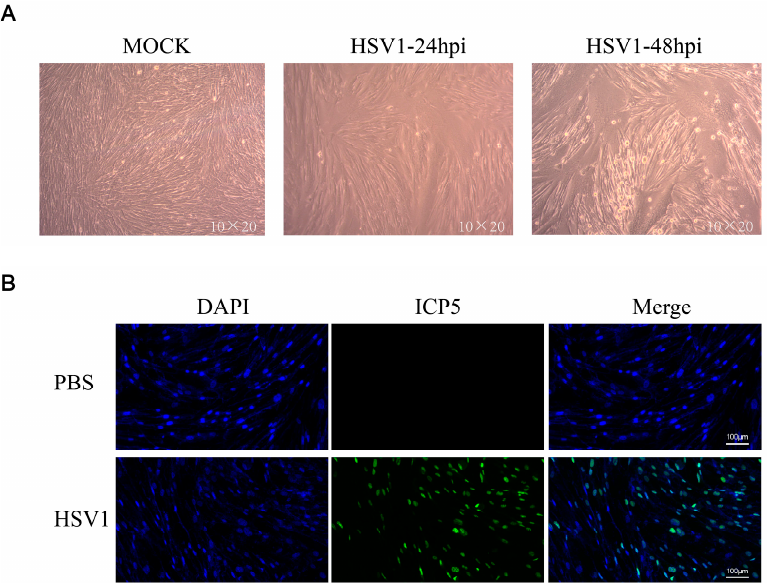
Figure 1. HSV-1 effectively infected KMB17 cells. ( A ) KMB17 was infected with HSV-1 (MOI = 0.1), cultured in 2% serum maintenance solution for 24 or 48 h, and recorded under microscope (10 × 20). In MOCK group, PBS was used as the control. After 48 h of incubation under the same conditions, the samples were observed and recorded under the microscope. ( B ) KMB17 cells were infected with HSV-1 (MOI = 0.1) and cultured in 2% serum maintenance solution for 24 h before immunofluorescence. Then, images were observed and collected under a fluorescence microscope. Blue is DAPI, and green is HSV1 virus late protein